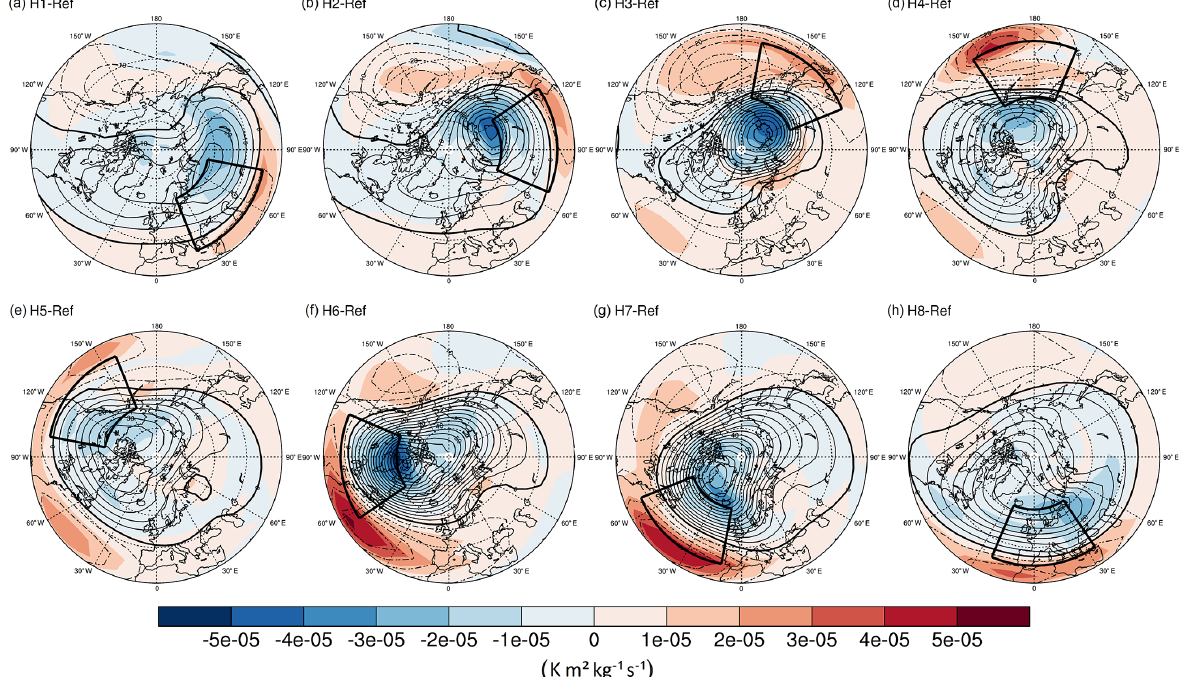
Figure 4. Polar plots of the geopotential height (contour lines) and potential vorticity (color coding) differences between the H1–H8 (a–h) and the Ref simulation averaged between 20 and 30km. Latitudes ranges from 30 ◦ N to the pole. Geopotential differences have a highlighted zero line and are presented in intervals of 5m. The dashed (solid) line represents negative (positive) differences. The positions of the GW hotspots are illustrated by the black